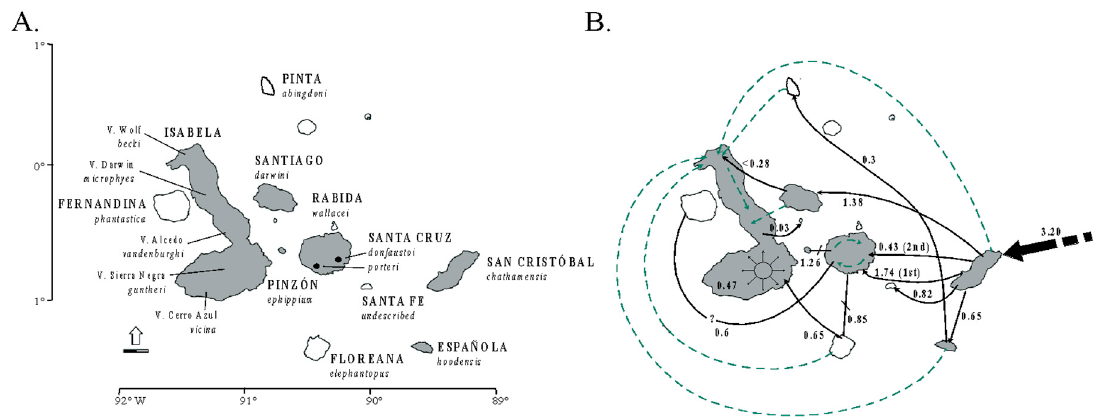
Figure 6. ( A ) The distribution of giant tortoises in the Galápagos Archipelago. The shaded and non-shaded islands indicate the presence of extant and extinct tortoise populations, respectively. The italicized names indicate current taxonomic designations. ( B ) A schematic of the proposed phylogeographic history of Galápagos giant tortoises modified from Poulakakis et al. (2012) [411]. The arrows represent dispersal and colonization events within Galápagos, with the numbers indicating approximate temporal order in millions of years. The short solid line segments indicate vicariance events. The solid black arrows are hypothesized natural colonization events, while the dashed arrows represent recent and likely human-induced translocations.